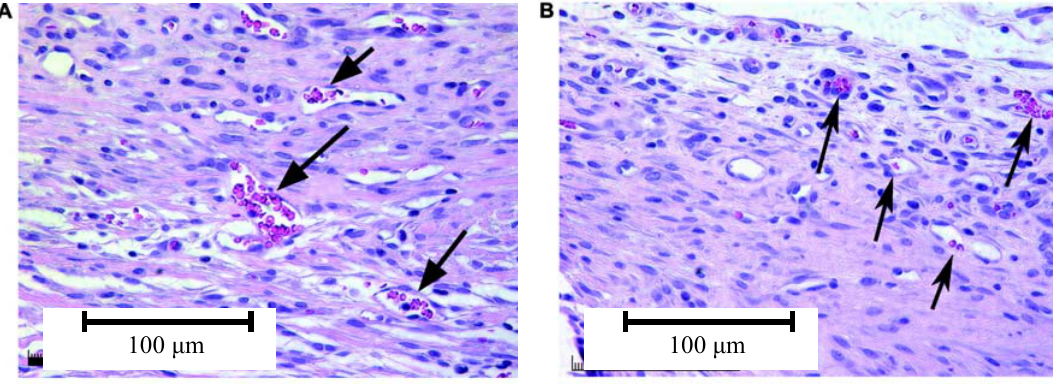
Figure 17. Two-week decalcified tissues stained with hematoxylin/eosin and treated with BG-loaded collagen sponge (A) or collagen control (B) Arrows denote blood vessels. Reprinted from ref. [211] with permission of Mary Ann Liebert.